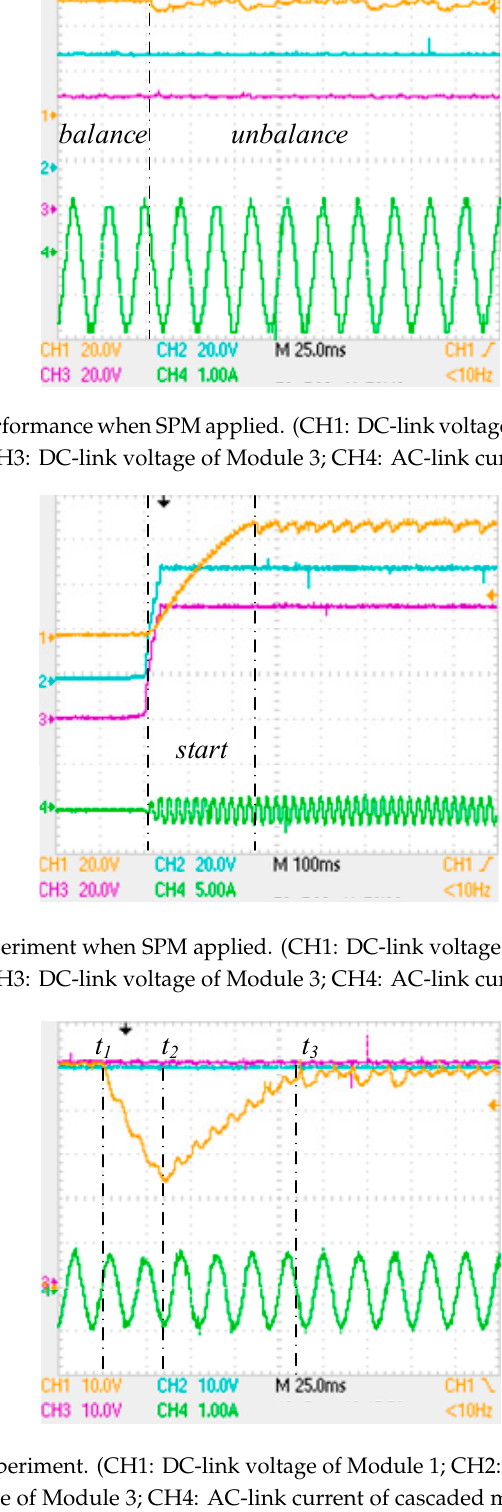
2; CH3: DC-link voltage of Module 3; CH4: AC-link current of cascaded modules).